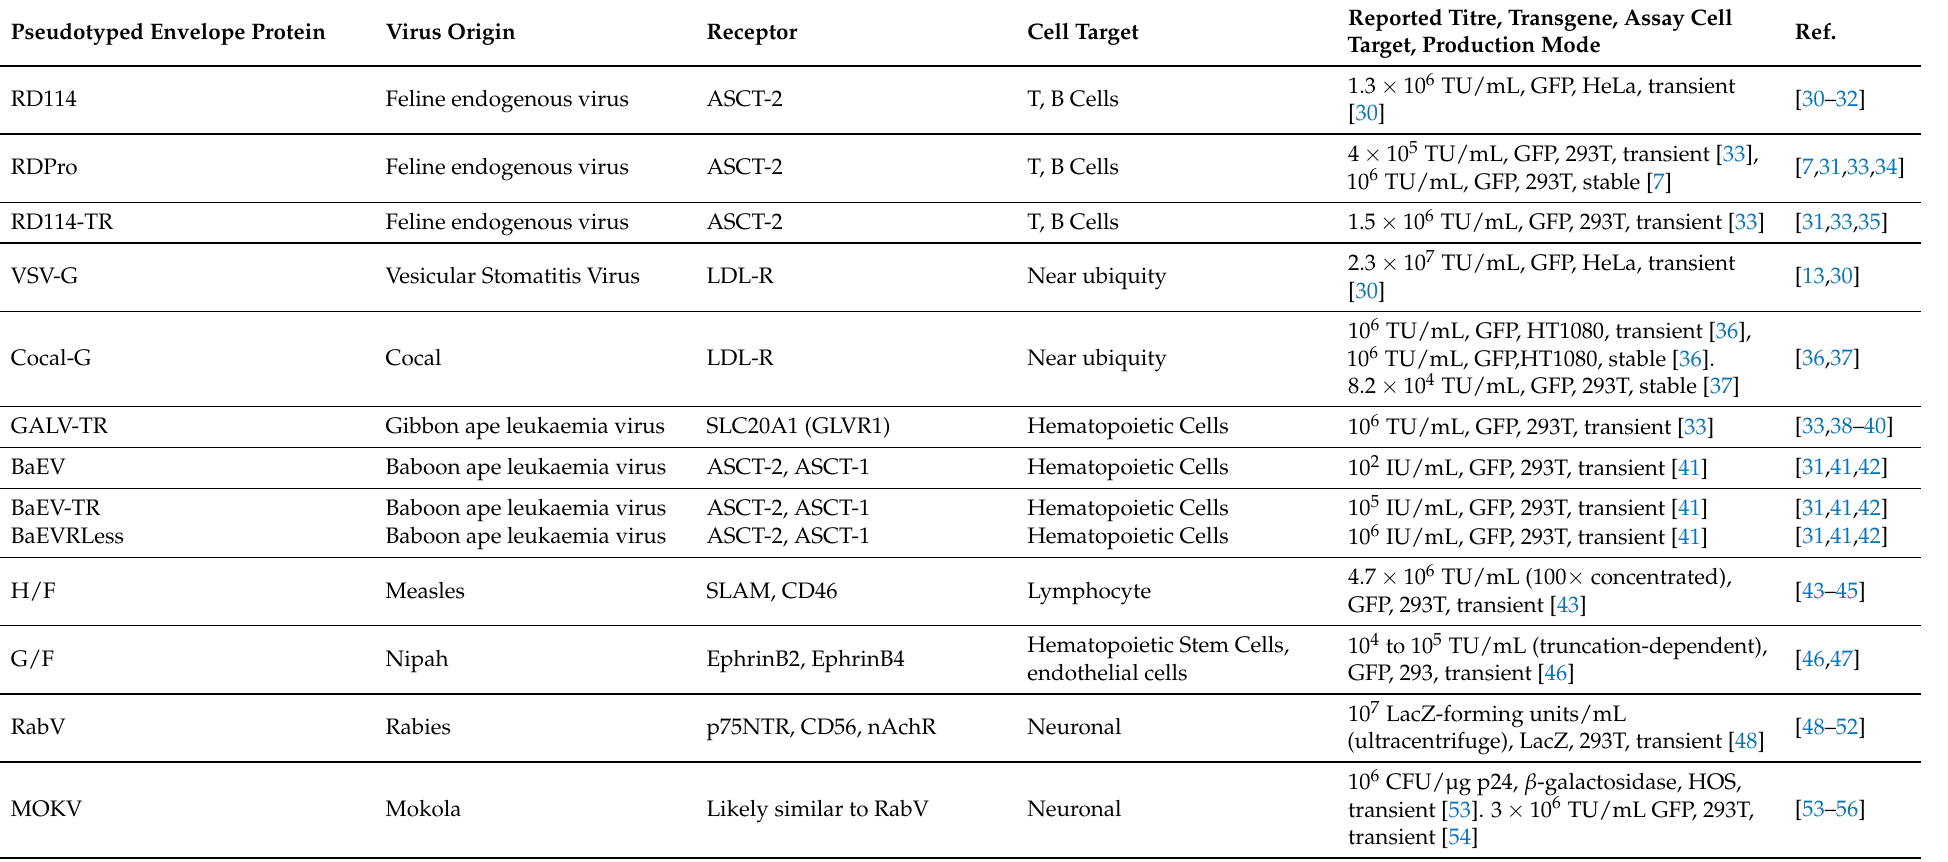
Table 2. Examples of envelope proteins that have been pseudotyped with lentiviral